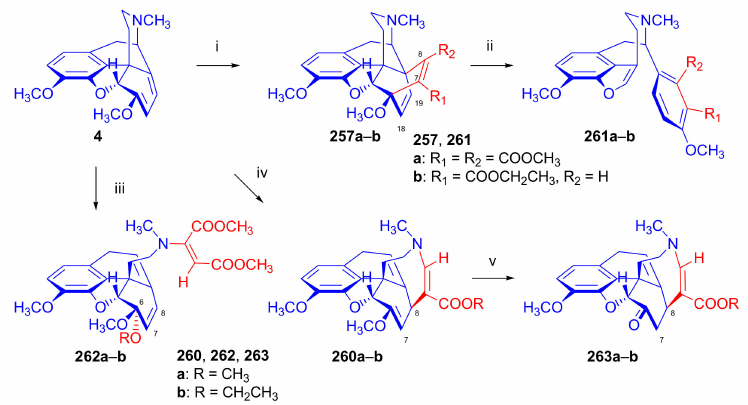
Figure 71. Reaction of thebaine with propargylic acid derivatives. Reagents and conditions : (i): DMAD or EP, benzene, 50 ◦ C, 1 h; (ii): di- n -butylether, reflux, 10–15 min; (iii): DMAD, methanol, room temperature, 30 min, (iv): MP or EP, acetonitrile, room temperature, 30 min; and (v): 10% aqueous oxalic acid room temperature, 45